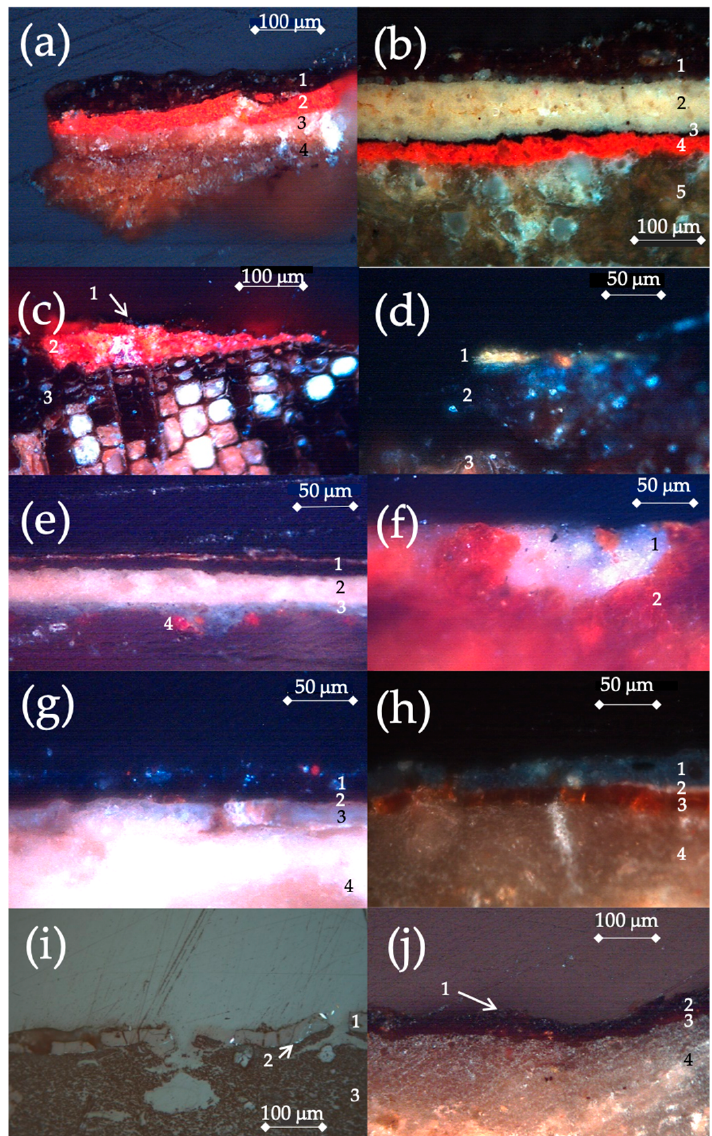
Figure 2. Microphotograph of the cross-sections of the 10 samples analyzed. Numbers in figures correspond to the different layers identified: ( a ) sample C-2 (XPL); ( b ) sample C-4 (XPL); ( c ) sample C-5 (XPL); ( d ) sample D-1 (XPL); ( e ) sample F-1 (XPL); ( f ) sample F-4 (XPL); ( g ) sample J-2 (XPL); ( h ) sample J-3 (XPL); ( i ) sample J-4 (PPL); ( j ) sample K-4 (XPL). PPL (plane-polarized light;